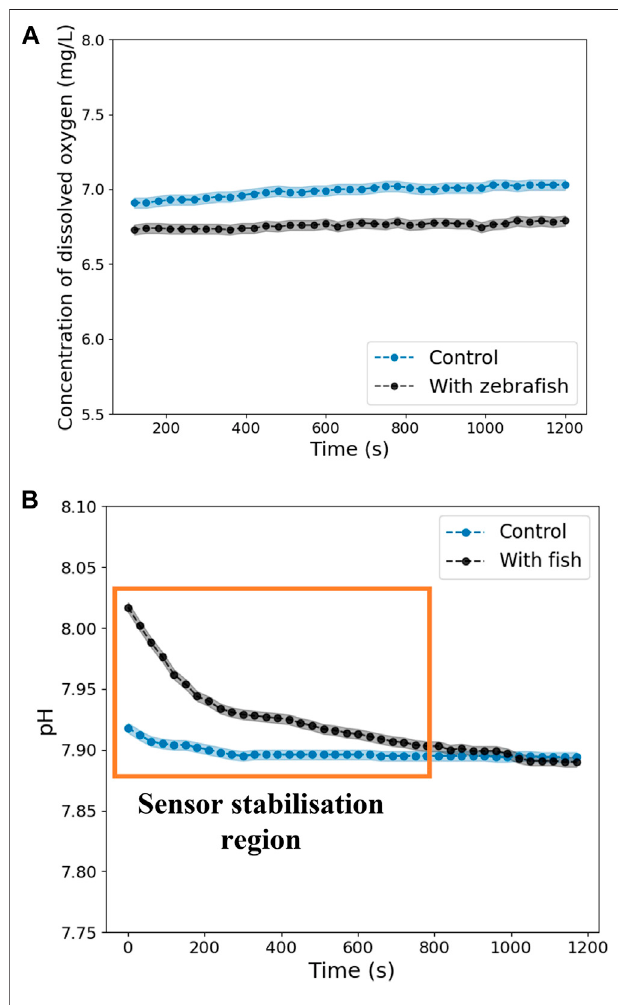
FIGURE 9 | Variation of the (A) concentration of dissolved oxygen and (B) pH over time with zebra fi sh and without